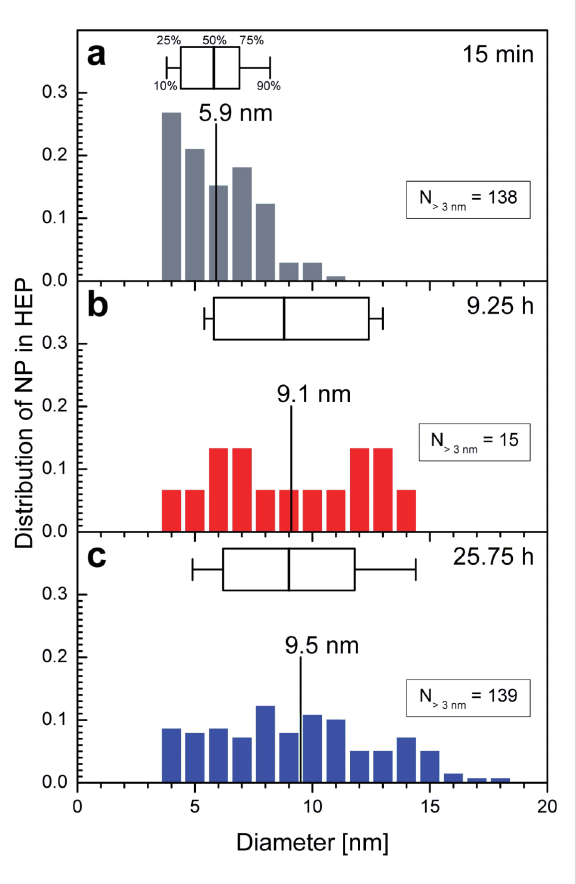
Figure 8: Distribution of the diameter of nanoparticles formed in the heterocyst polysaccharide layer (HEP) of Anabaena cylindrica as ob- tained from TEM images with 50k. Distributions of nanoparticles larger than the reliable detection limit of 3 nm are shown (a) after 15 minutes, (b) after 9.25 hours and (c) after 25.75 hours of incubation with an overall concentration of 0.8 mM Au 3+ . In each panel the mean size (vertical labeled line) is shown as well as a box plot (25% | 50% | 75%) with whiskers for 10% and